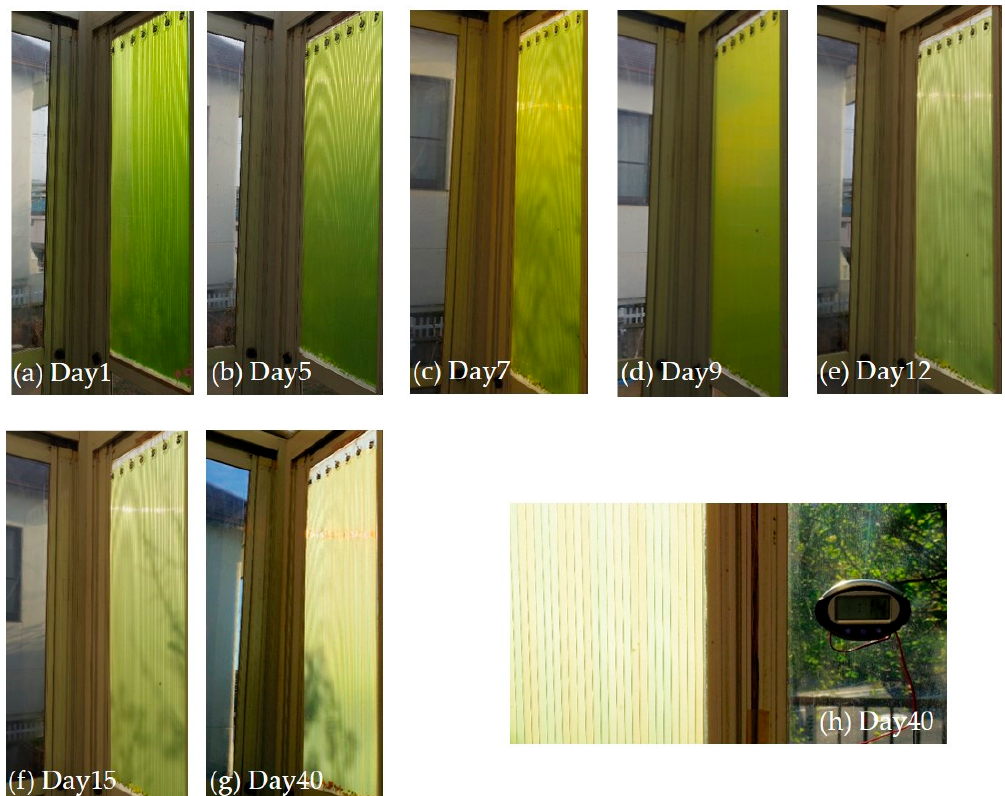
Figure 10. Time dependence of the color of the PSII window. On the other hand, the color change of the PSII roof is different from that of the PSII window. Figure 11 shows the time dependence of the color of the PSII roof. As shown of green color changes to semitransparent light yellow after 18 days, and the clock is still working, as shown in Figure 11h, although the clock stops after 19